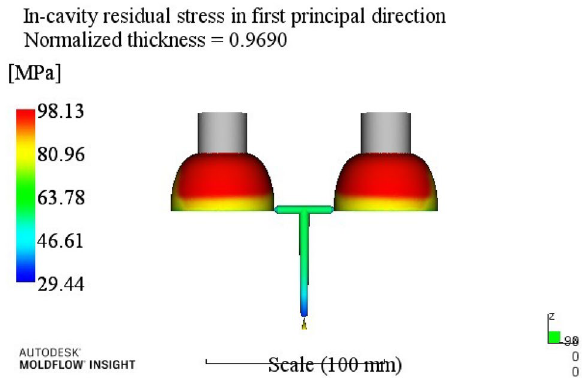
Figure 14. The optimized The first direction residual stress.